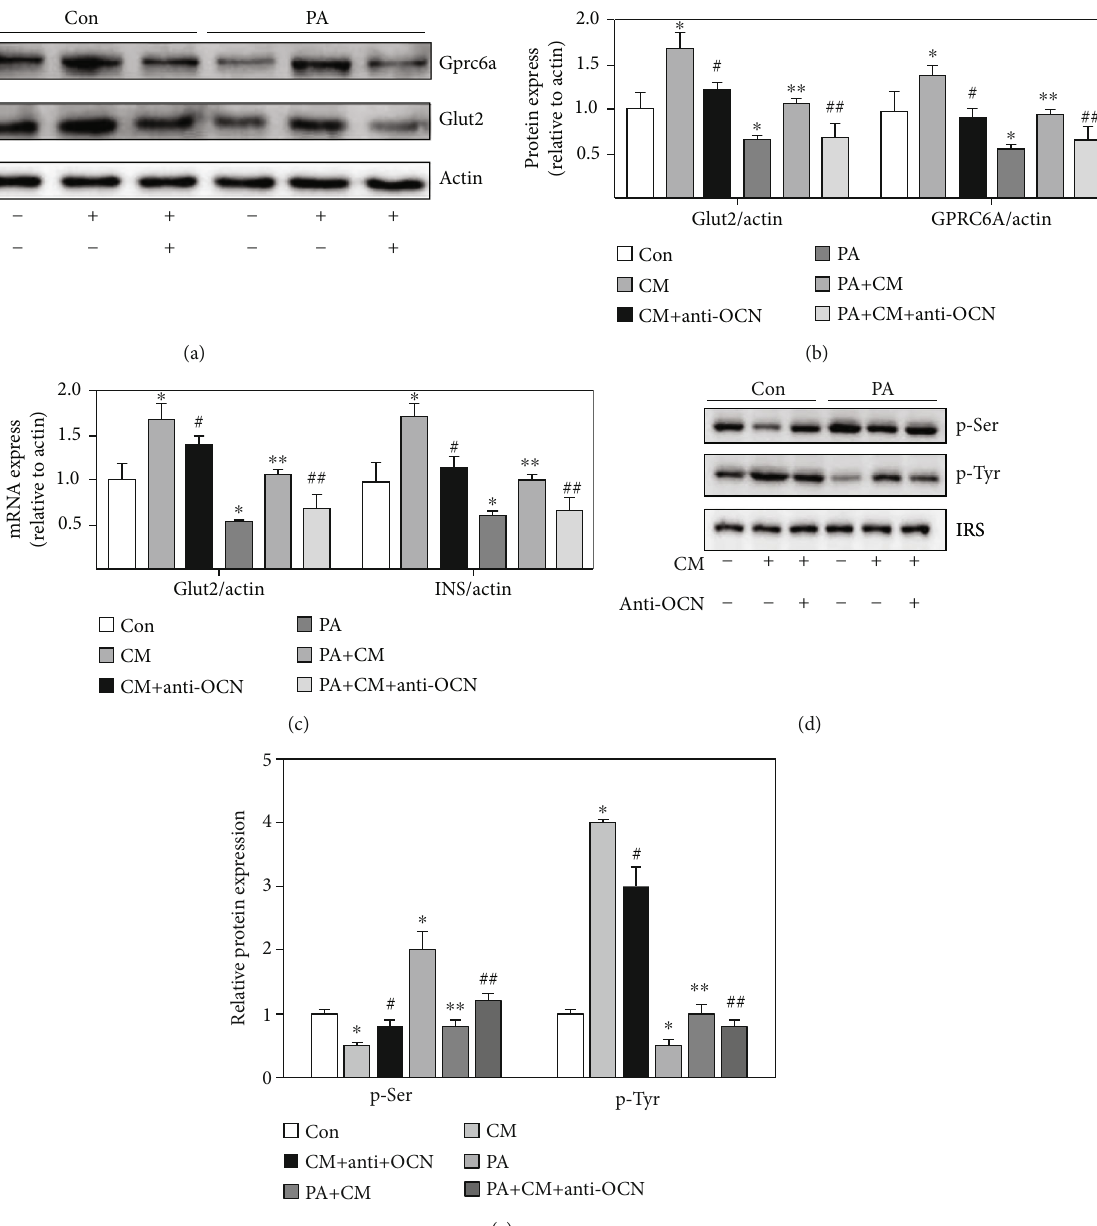
Figure 4: The increase of insulin by CM was reversed by Anti-OCN. (a) The protein expression of Gprc6a and Glut2 was measured through western blotting after treatment with CM or Anti-OCN. (b) The protein expression of Gprc6a and Glut2 was analyzed. (c) The mRNA expression of Gprc6a and Glut2 was measured through qRT-PCR after treatment with CM or Anti-OCN. (d) The serine and threonine phosphorylation of insulin receptor substrate 1 (IRS-1) were measured through western blotting after treatment with CM or Anti-OCN. (e) The serine and threonine phosphorylations of insulin receptor substrate 1 (IRS-1) were analyzed. Compared with the control group, ∗ P < 0 : 05 . Compared with the PA group, ∗∗ P < 0 : 05 . Compared with the CM group, # P < 0 : 05 . Compared with the PA +CM group, ## P < 0 : 05 . Beta-TC6 was used in these